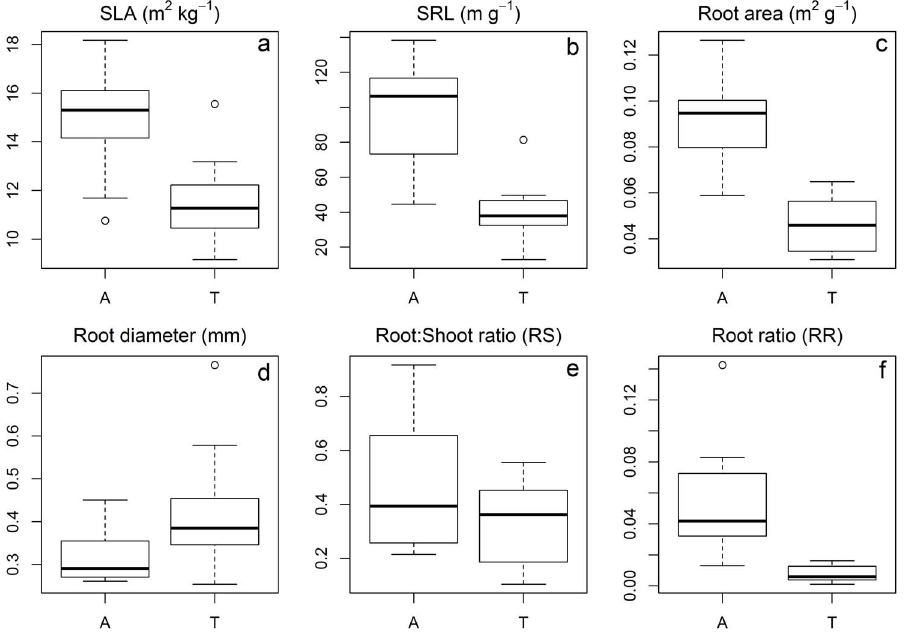
Figure 2. The functional traits and biomass allocations of aquatic (A) and terrestrial (T) reed (a, specific leaf area (SLA); b, specific root length (SRL); c, mean root area of unit mass (R area ); d, mean root diameter (R diam ); e, Root:Shoot ratio (RS); f, root ratio (RR)).